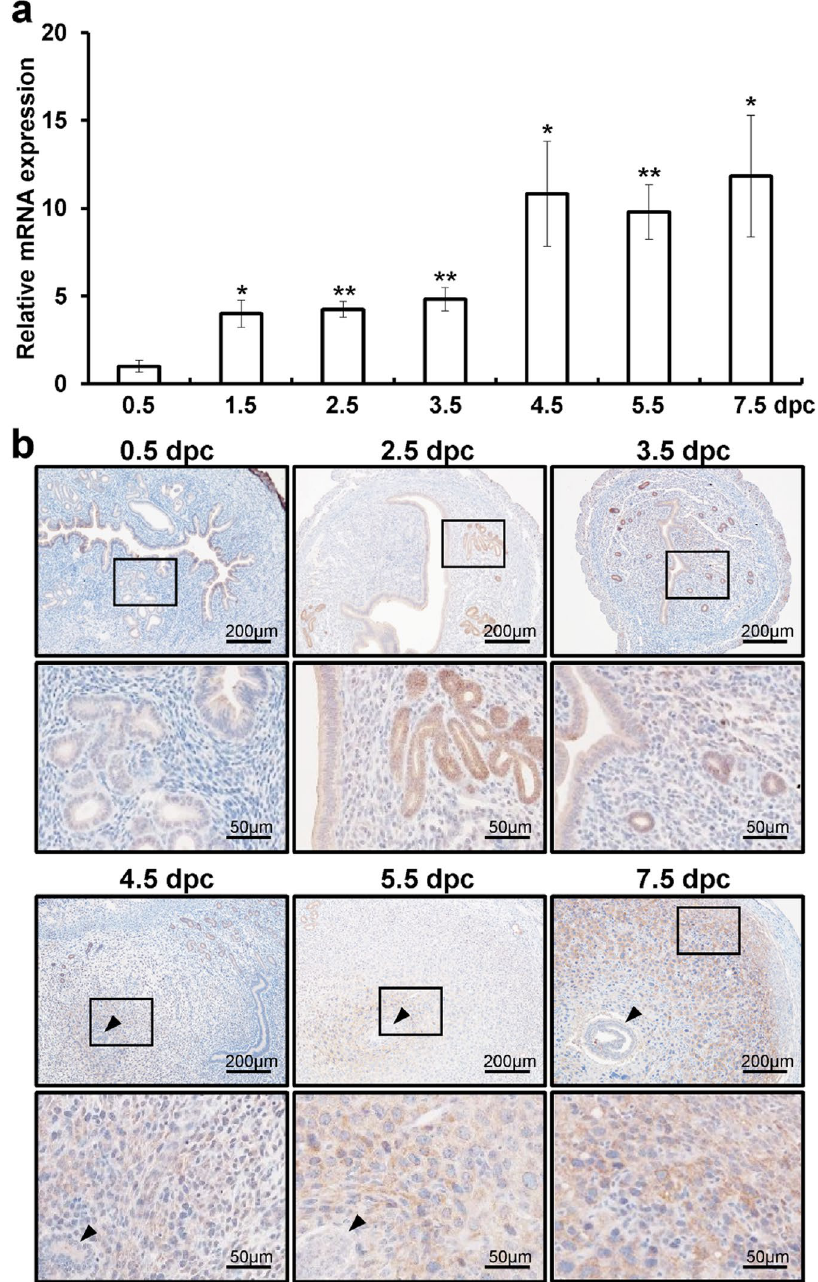
Figure 1. The expression patterns of Gpr64 during early pregnancy. ( a ) The expression levels of Gpr64 were measured in uteri during early pregnancy. Total RNA used for the quantitative real-time PCR assays was prepared from early pregnancy uteri. The results represent the mean ± SEM of three independent RNA sets. * p < 0.05 and ** p < 0.01. ( b ) The immunohistochemistry analysis of GPR64 during natural pregnancy was investigated at 0.5 dpc, 2.5 dpc, 3.5 dpc, 4.5 dpc, 5.5 dpc, and 7.5 dpc. Black arrow head indicates embryo. Nuclei were counterstained with